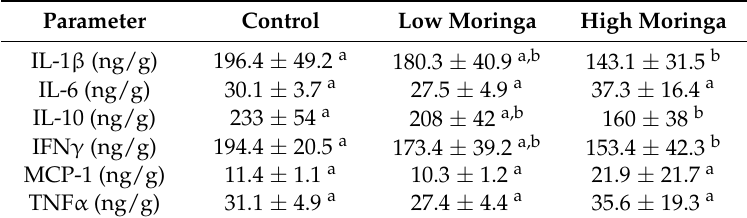
1 Values are means ± SD, n = 8; Values in the same row with different superscripts are significantly different at p < 0.05 using Tukeys’ test as post-hoc test. IFN γ , Interferon γ ; MCP-1, monocyte chemoattractive protein-1.